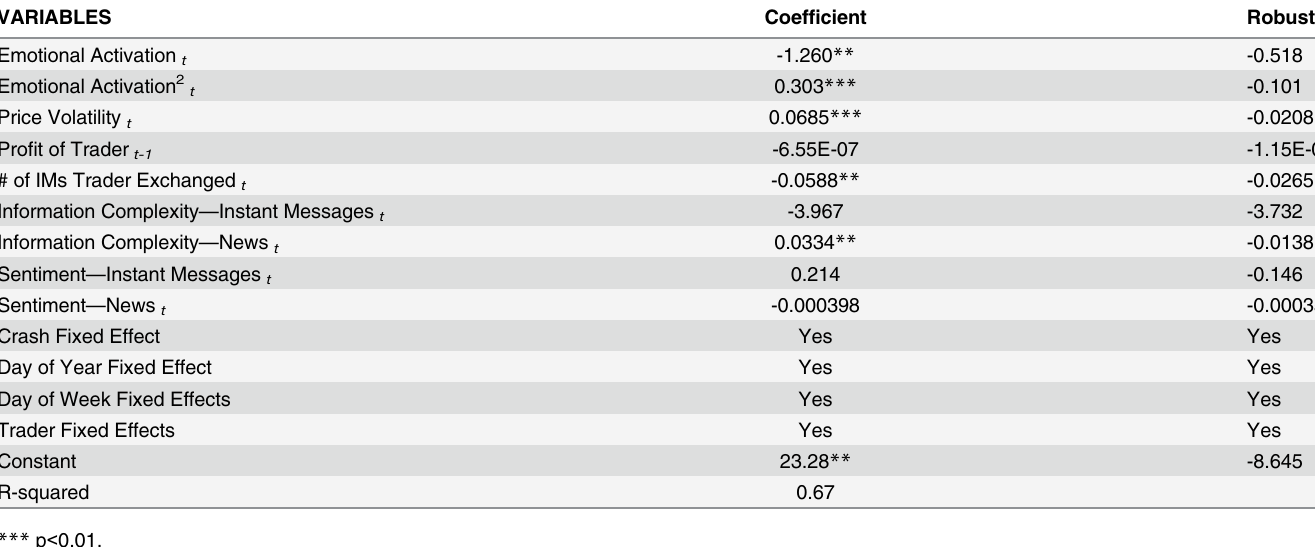
Table 1. Daily Median Errors in Stock Trading and Daily Emotional Activation as Measured via Online Communications. Fixed effect regression showing the relationship between changes in the daily emotional activation of day traders and the size of their trading decision errors as measured by the deviation in trading profits from the optimal trades for the day that could have taken place within the same 5 minute window as the actual trade that did take place. Results suggest an inverted U shaped relationship between the magnitude of decision errors and the level of emotional activation of the decision maker. Consistent with prior work, the more IMs exchanged by a trader the better their trading decisions [18 – 19]. Robust standard errors clustered on trader ID showing are shown. SI File presents null models, robustness checks, and detailed explanations of control